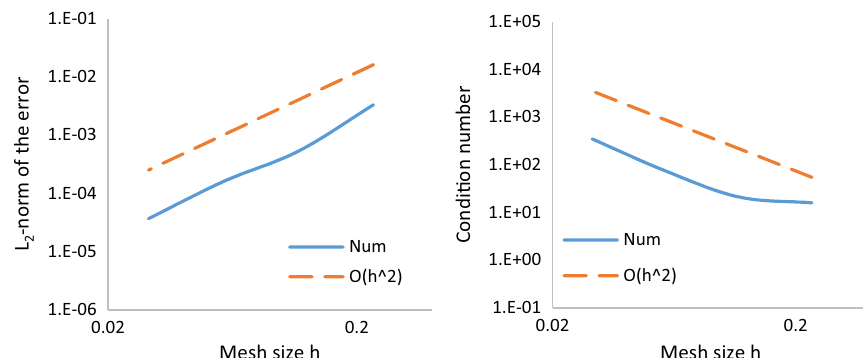
Fig. 23 Plot of the L 2 -norm of the error and 2-norm condition number